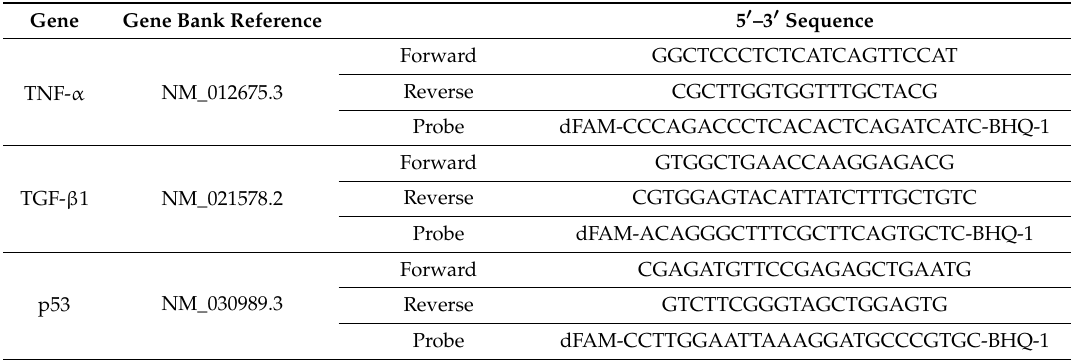
Table 1. Forward and reverse primers and fluorogenic probe sequences used for real time quantitative PCR